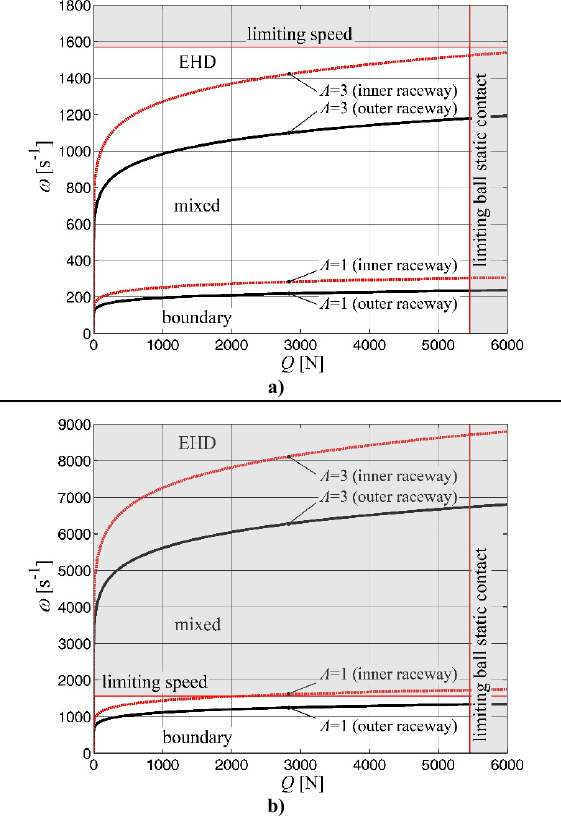
Figure 4. A plot that shows a lubrication regime dependence of angular speed ω and contact load F for rolling bearing 6206 and lubricant Advanced Ester, with surfaces roughness of R ar =0.14 μ m and R ab =0.05 μ m and operating temperature of a) 38°C, b) 99°C